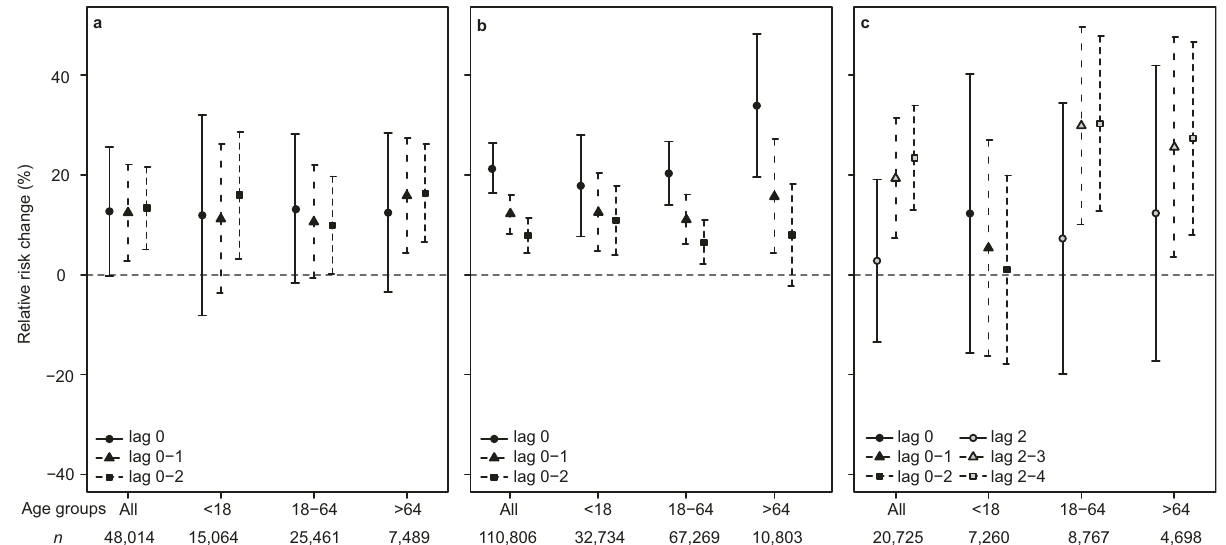
Fig. 4 Mature plume exposure and respiratory health outcomes on no-advisory days. Associations between mature plume exposure and respiratory health outcomes from regression models on days when no public advisories were issued for ( a ) AMD, n = 48,014 individuals; b PCMD, n = 110,806 individuals; c HED, n = 20,725 individuals. Results are reported as percent change in RR with error bars showing the 95% con fi dence intervals. Results are shown for different age groups (all age groups combined; <18 years; 18 – 64 years; >64 years) for several lag combinations; n of individuals in each age group is shown on the x-axis. Lag 0 = the day of the exposure, Lag 1 = one day after the exposure, Lag 0 = the day of the exposure, lag 1 = one day after the exposure, lag 2 = two days after the exposure, lag 0 – 2 = mean of lag 0, 1, and 2, lag 2 – 3 = mean of lag 2 and 3, lag 2 – 4 = mean of lag 2, 3 and 4. On ( c ), the association between exposure and HED visits are shown for combinations of lag 2 – 4 in adults and elderly; in children, combinations of lag 0 – 2 are shown as there was no signi fi cant change for other age